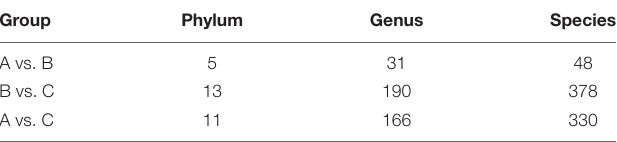
TABLE 1 | Statistical table of abundance difference